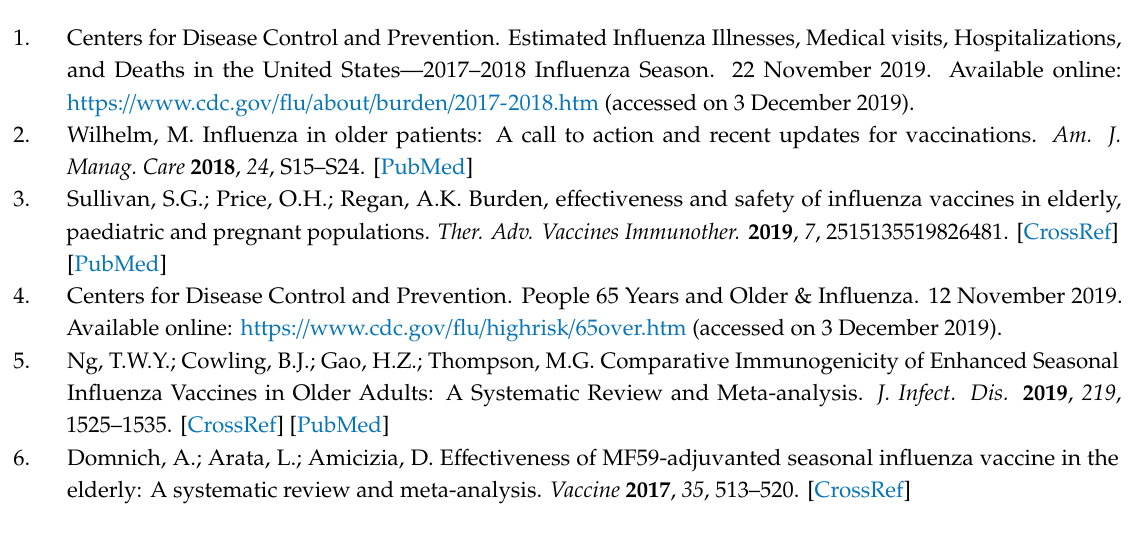
Baseline Demographic Characteristics—Unadjusted,